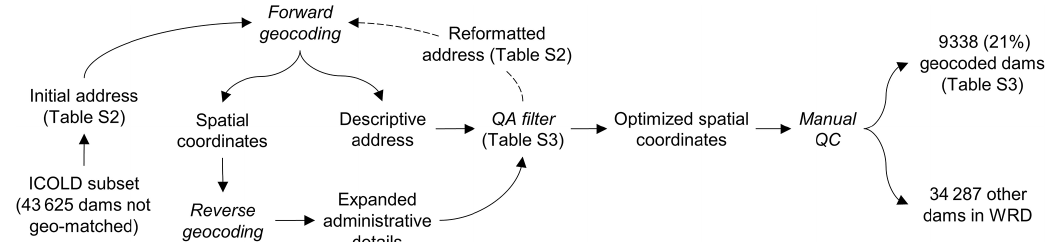
Figure 4. Schematic procedure of geocoding using Google Maps API. Text in roman indicates applied or produced datasets, and text in italics indicates methods or procedures. The dashed line arrow indicates that this step is not always